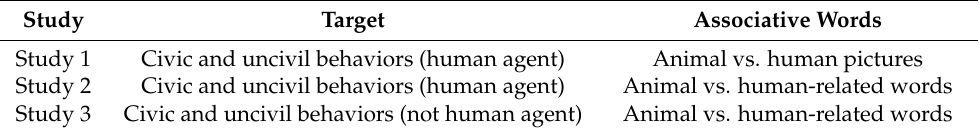
Table 1. Overview of the